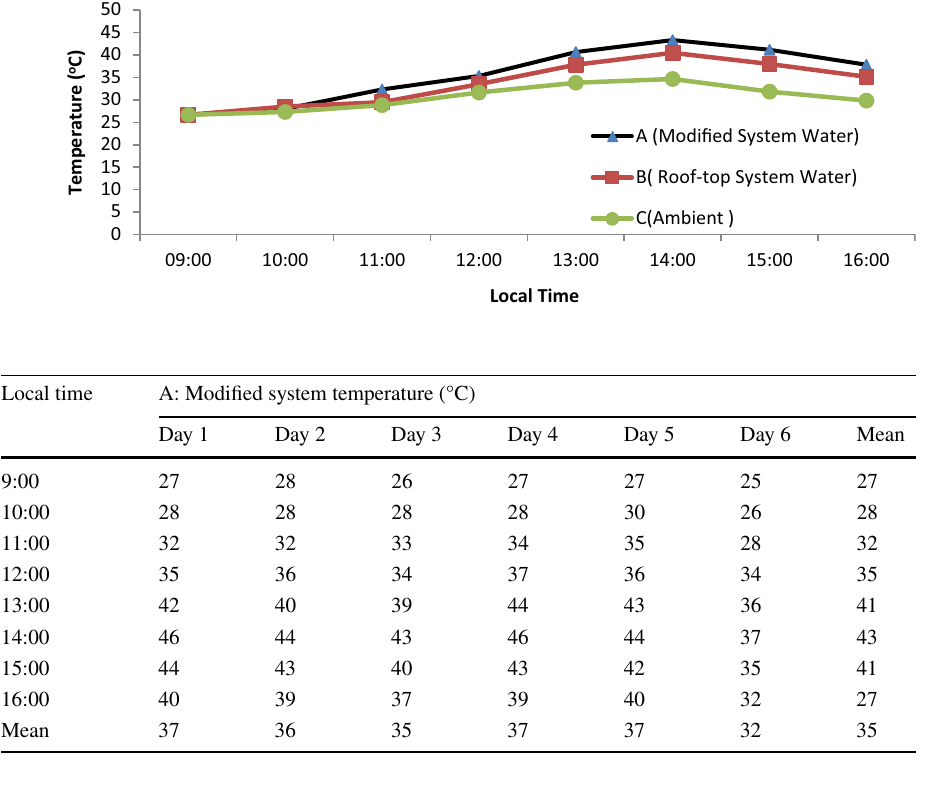
Table 2 Variation in daily hourly water temperature of PET bottles of the rooftop SODIS during the experiment